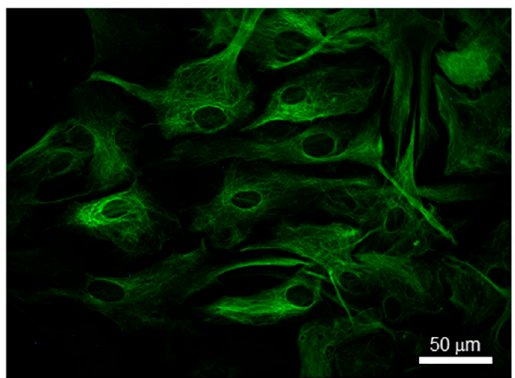
Figure 2. Astrocytes from a culture characterized by anti-GFAP labeling (green staining).